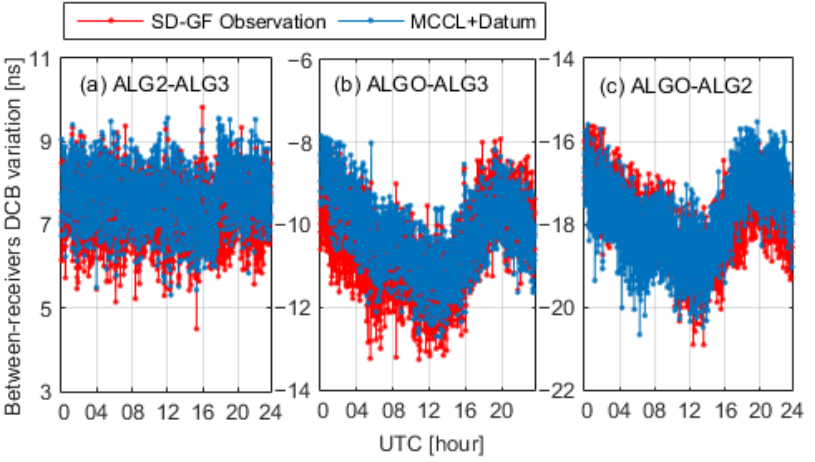
Figure 4. Epoch-by-epoch estimates of BR-DCB using SD-GF method (red line) and MCCL plus datum method (blue line) for three pairs of co-located receivers: ALG2-ALG3, ALGO-ALG3, ALGO-ALG2 on DOY 07, 2017.